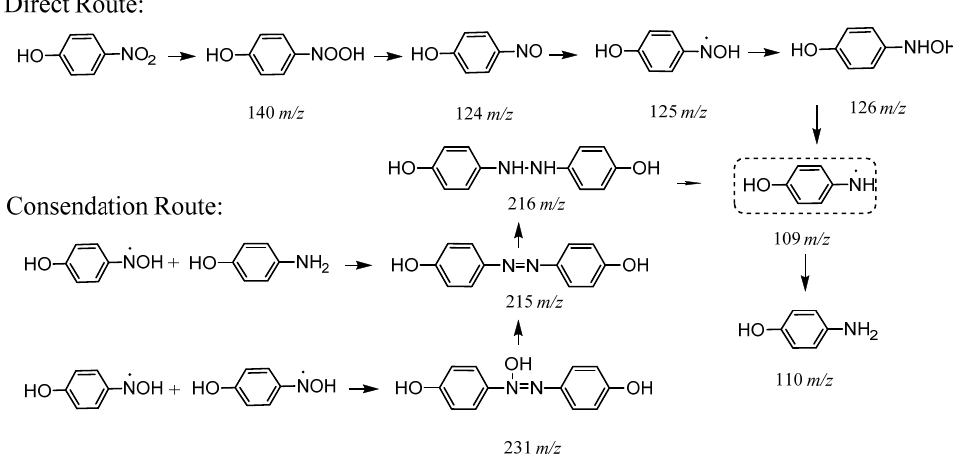
Figure 4. The mechanism diagram proposed by Haber and Gelder [1,13,15] ( a ) The Haber mechanism and ( b ) reaction mechanism for nitrobenzene hydrogenation proposed by Gelder.